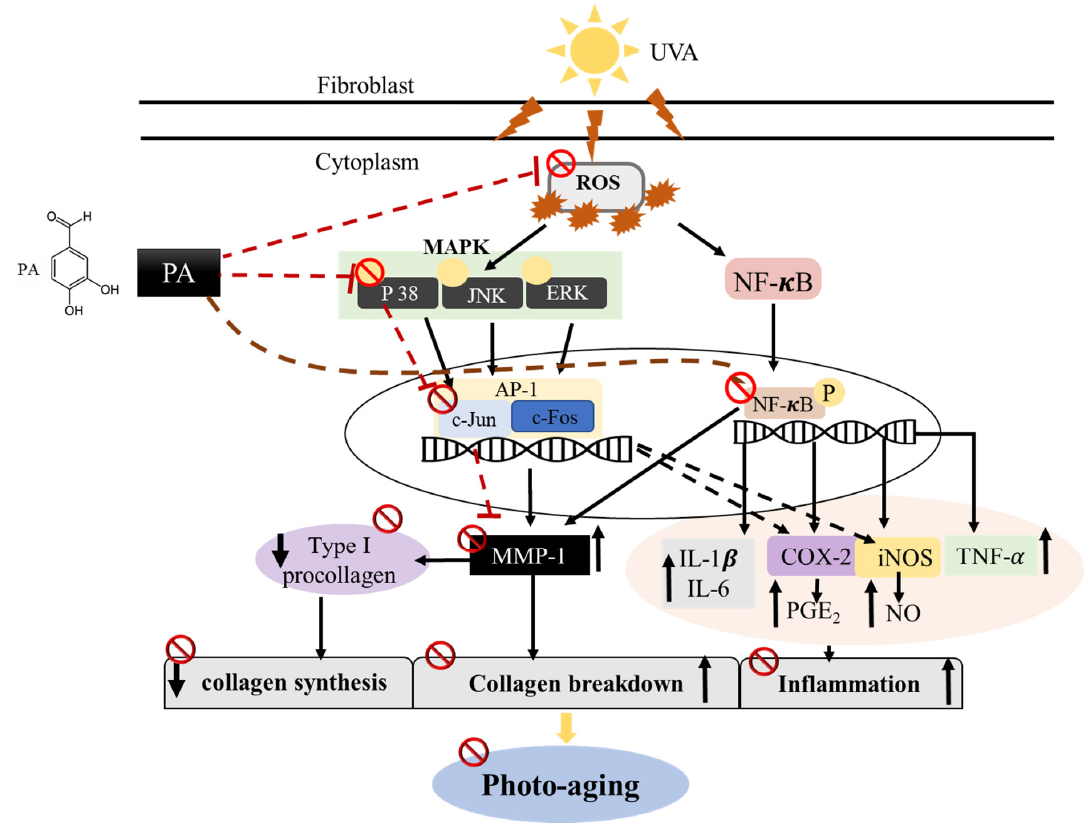
Figure 8. Proposed mechanism for attenuation of UVA-induced photoaging by PA in HDF cells.